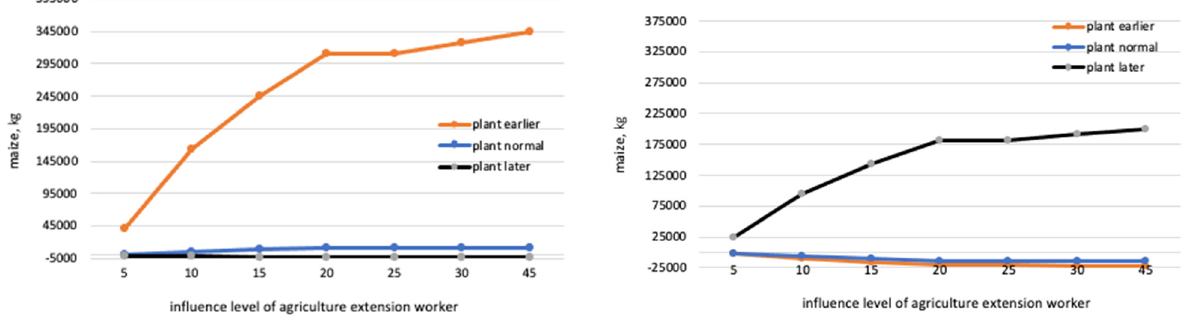
Figure 10. Farmer interaction with agriculture extension workers.